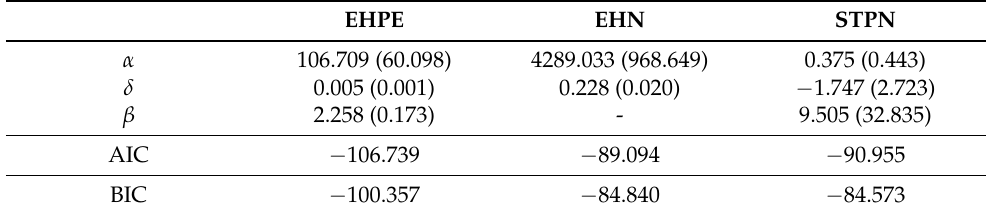
Table 7. Estimated parameters and their standard errors (in parentheses).